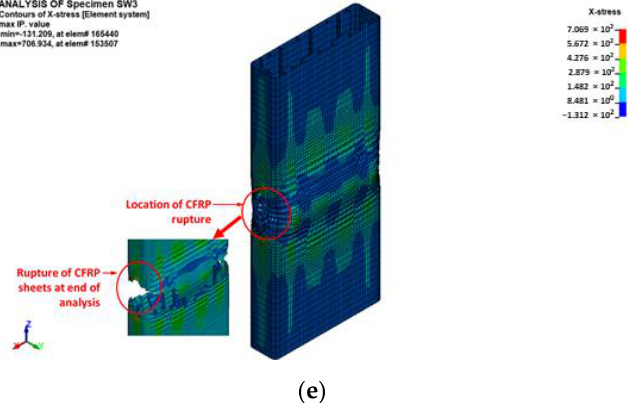
Figure 24. FE mode of failure for strengthened specimens SW3 and SW4: ( a ) bulging of CFRP sheets at peak load; ( b ) effective plastic stress contours for concrete elements; ( c ) axial stress contours for main rebar elements; ( d ) axial stress contours for NSM rebar elements; and ( e ) X-stress contours for shell elements of CFRP sheets.